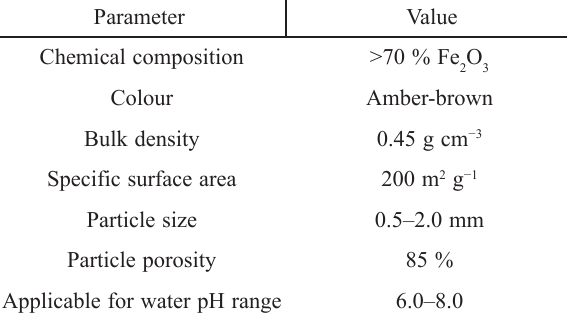
Table 1 – Physicochemical properties of GFO